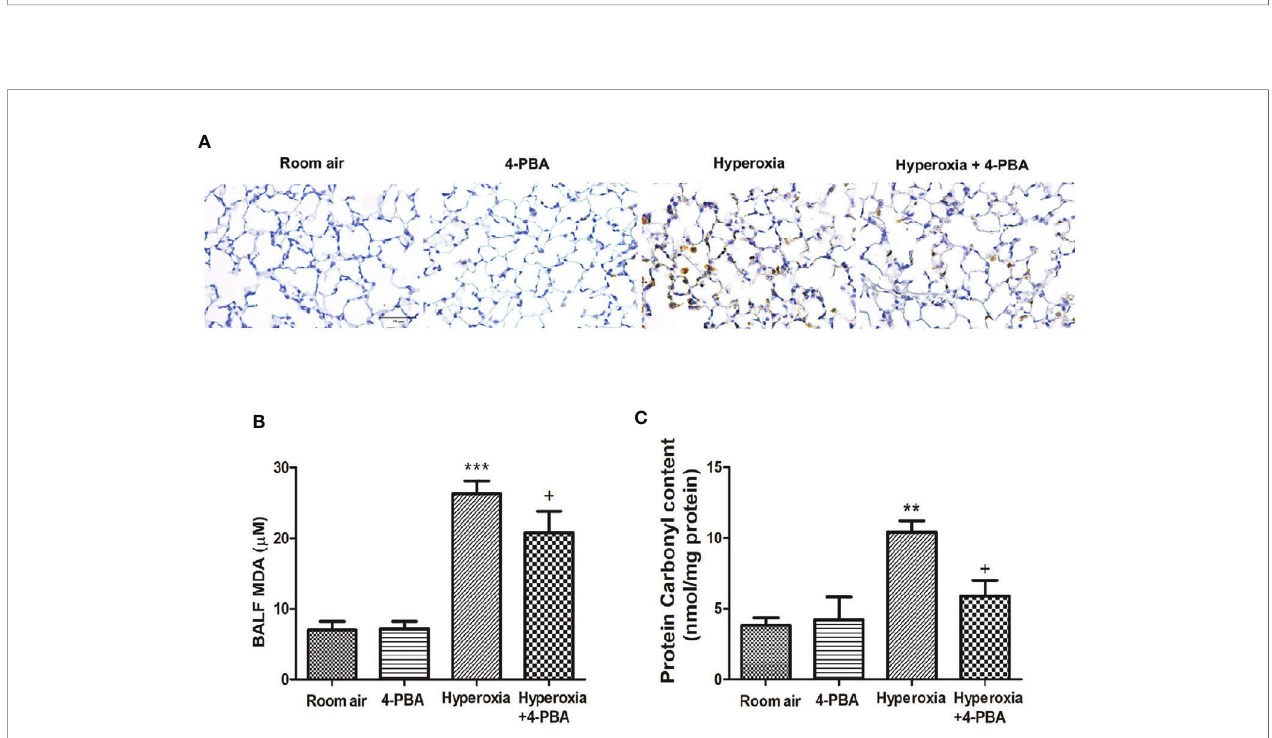
FIGURE 3 | 4-PBA attenuates hyperoxia-induced oxidative stress in lung tissue. Immunohistochemical staining (×200) of MPO in 72 hours after hyperoxia (A) . The MDA levels in the BALF (B) , and protein carbonyl contents (C) in lung tissues were analyzed by ELISA. Data are expressed as mean ± SD (6 mice per group). **p < 0.01, ***p < 0.001, compared with the room air group; + p < 0.05 compared with the hyperoxia